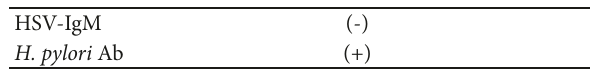
Table 1: Laboratory data on admission. Table 1: